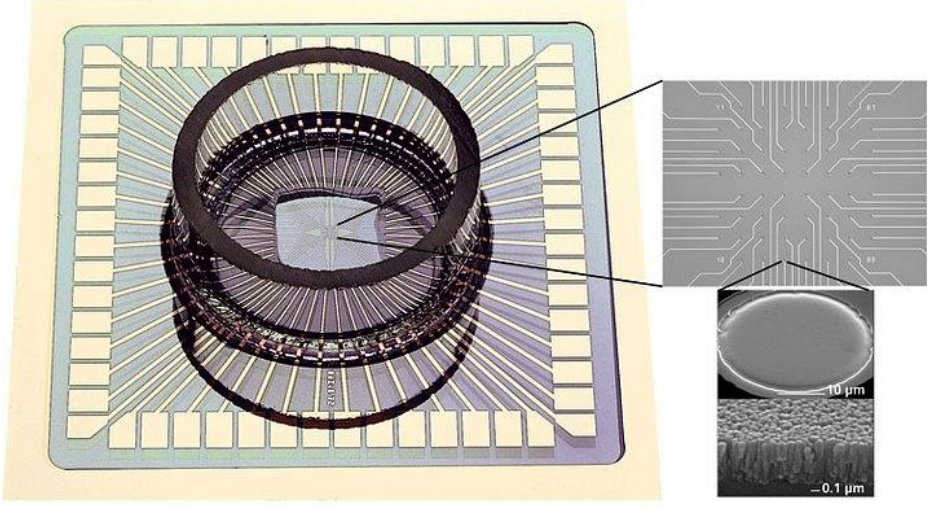
Figure 10. A Multi Channel Systems MEA. The magnified images show the array of 64 electrodes and further SEM images showing a single electrode and its surface. The lower image shows the high surface area dendritic TiN (from